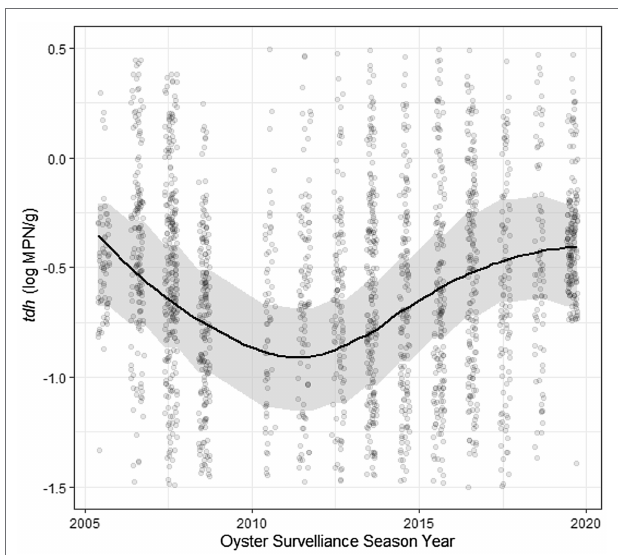
FIGURE 5 | Sinusoidal trend of log tdh values across time. Plotted results of univariate model coefficients shown in Table 6 .